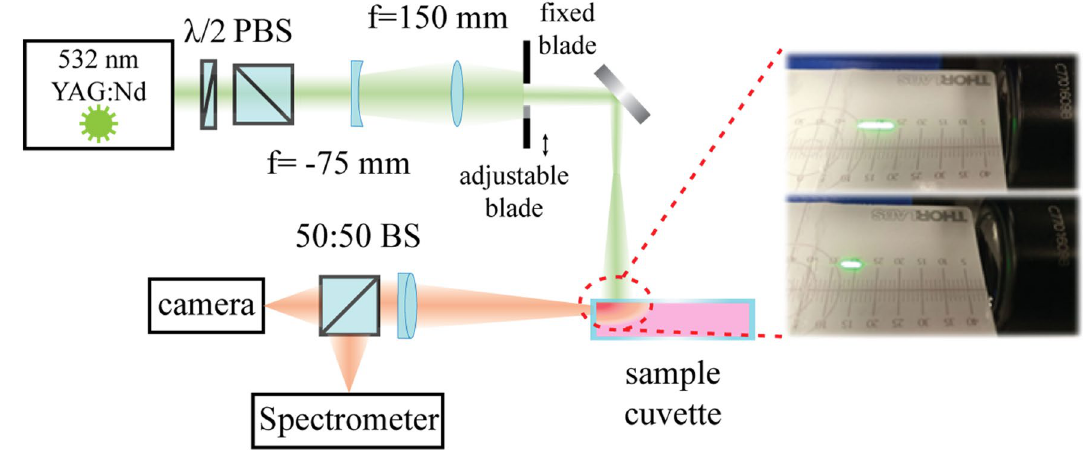
Figure 4. Schematics of the experimental setup. Right insets—photographs of slit illuminations with variable